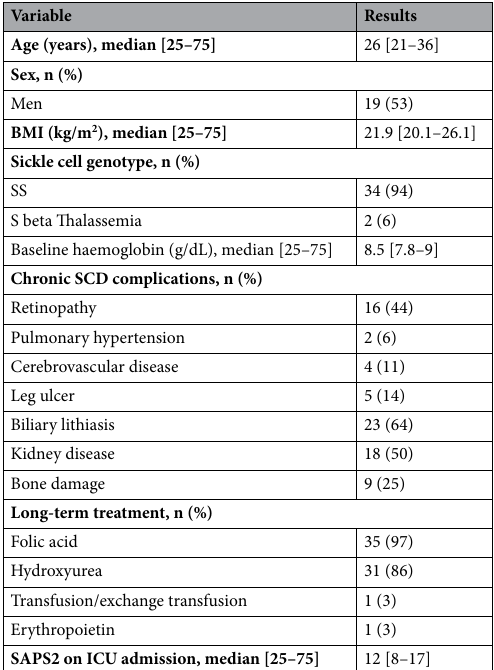
Table 1. Baseline characteristics of the 36 patients enrolled. Results are reported as median and inter-quartile range [25–75] or number and frequency. BMI: Body mass index; SAPS2: Simplified Acute Physiology Score 2; ICU: intensive care unit.